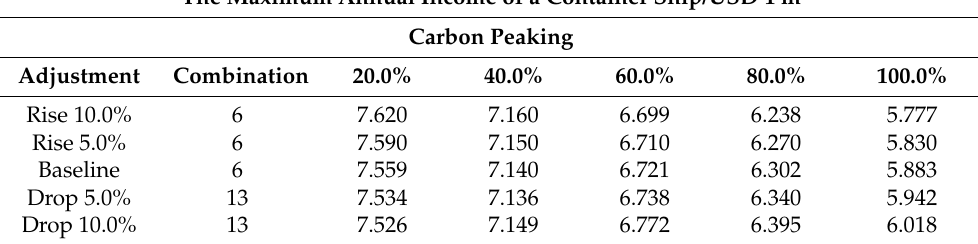
Table 9. Sensitivity analysis of auction and purchase prices of carbon.